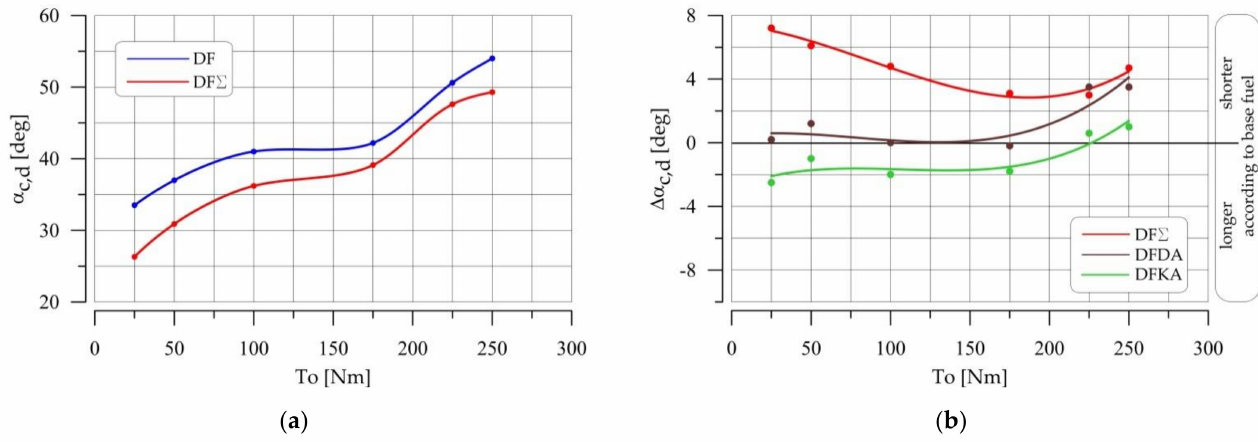
Figure 25. ( a ) Duration of diffusion combustion vs. engine torque; ( b ) Difference in diffusion combustion duration vs. engine torque in relation to the base